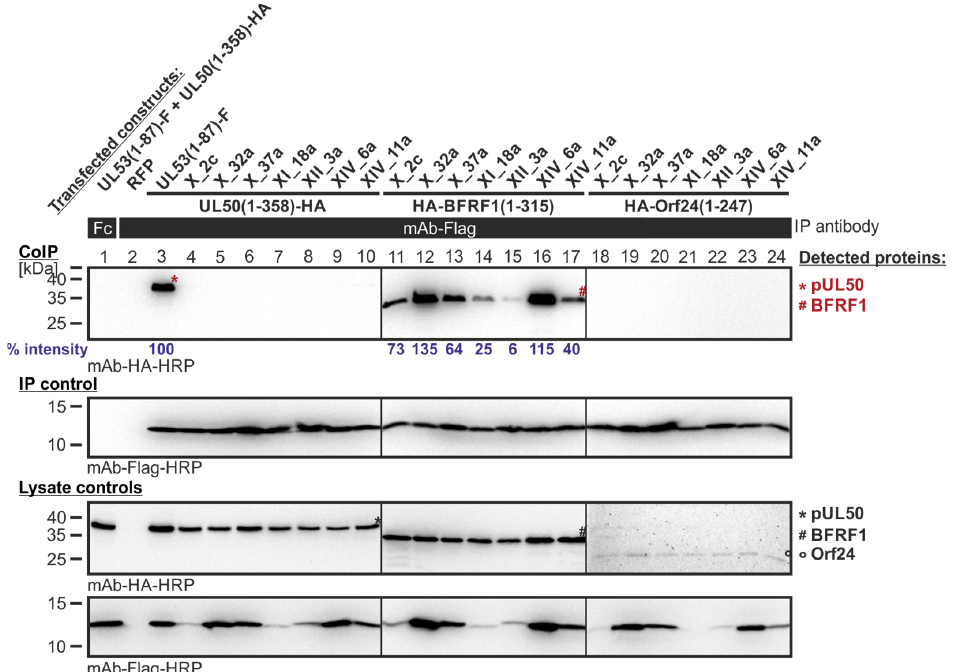
Figure 9. CoIP ‐ based interaction analysis of HCMV pUL50, EBV BFRF1 and VZV Orf24 with the library clones that exerted shared ‐ hook binding activity in the primary screening of Lib2 with BFRF1. 293T cells were transiently transfected with plasmids coding for the HA ‐ tagged groove proteins, pUL50, BFRF1, or Orf24, lacking their TMD, in combination with the Flag ‐ tagged library constructs. The wild ‐ type interaction of truncated pUL53 with pUL50 served as a positive and RFP as a negative control. At three d p.t., cells were lysed and Flag ‐ tagged proteins were immunoprecipitated using mAb ‐ Flag; a chicken Fc fragment served as a specificity control. Lysate controls taken prior to the IP and CoIP samples were subjected to standard Wb analysis using tag ‐ specific antibodies as indicated. Blue numbers: each individual CoIP band was first normalized to the corresponding IP signal and was then set in relation to the reference WT interaction (% intensity) using Aida Image Analyzer v.4.23 software (mean values of triplicate densitometric determinations are given); CoIP was performed once.